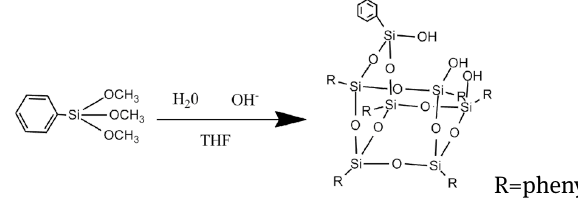
Figure 2: Synthesis of